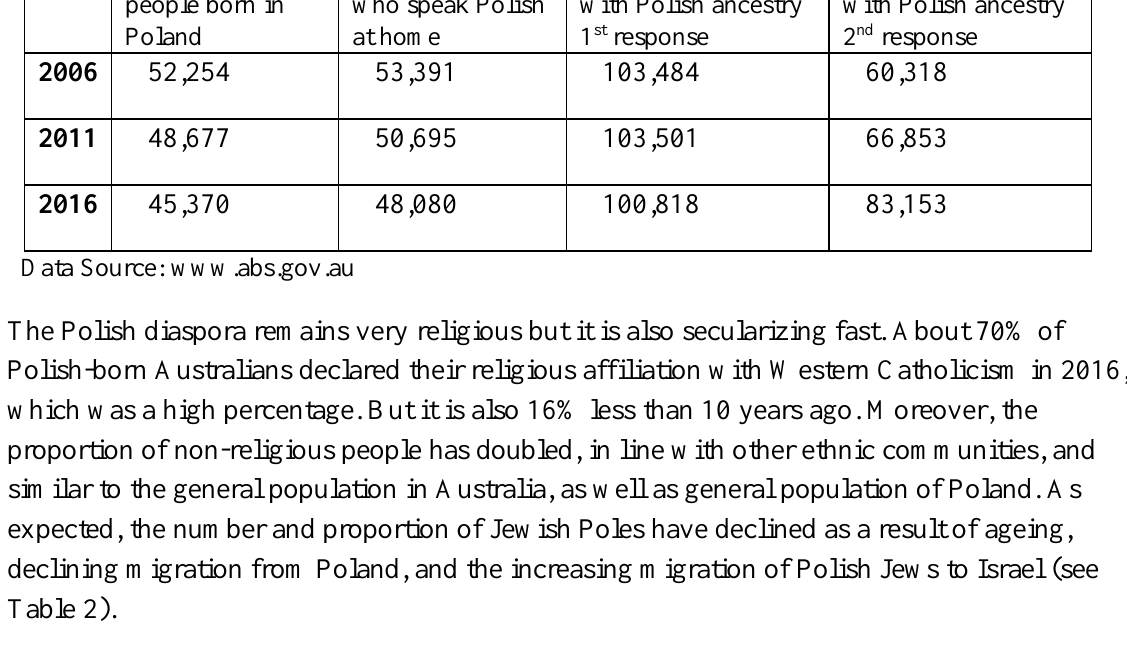
Table 1. Australian residents of Polish ancestry: census of population data Number of people born in